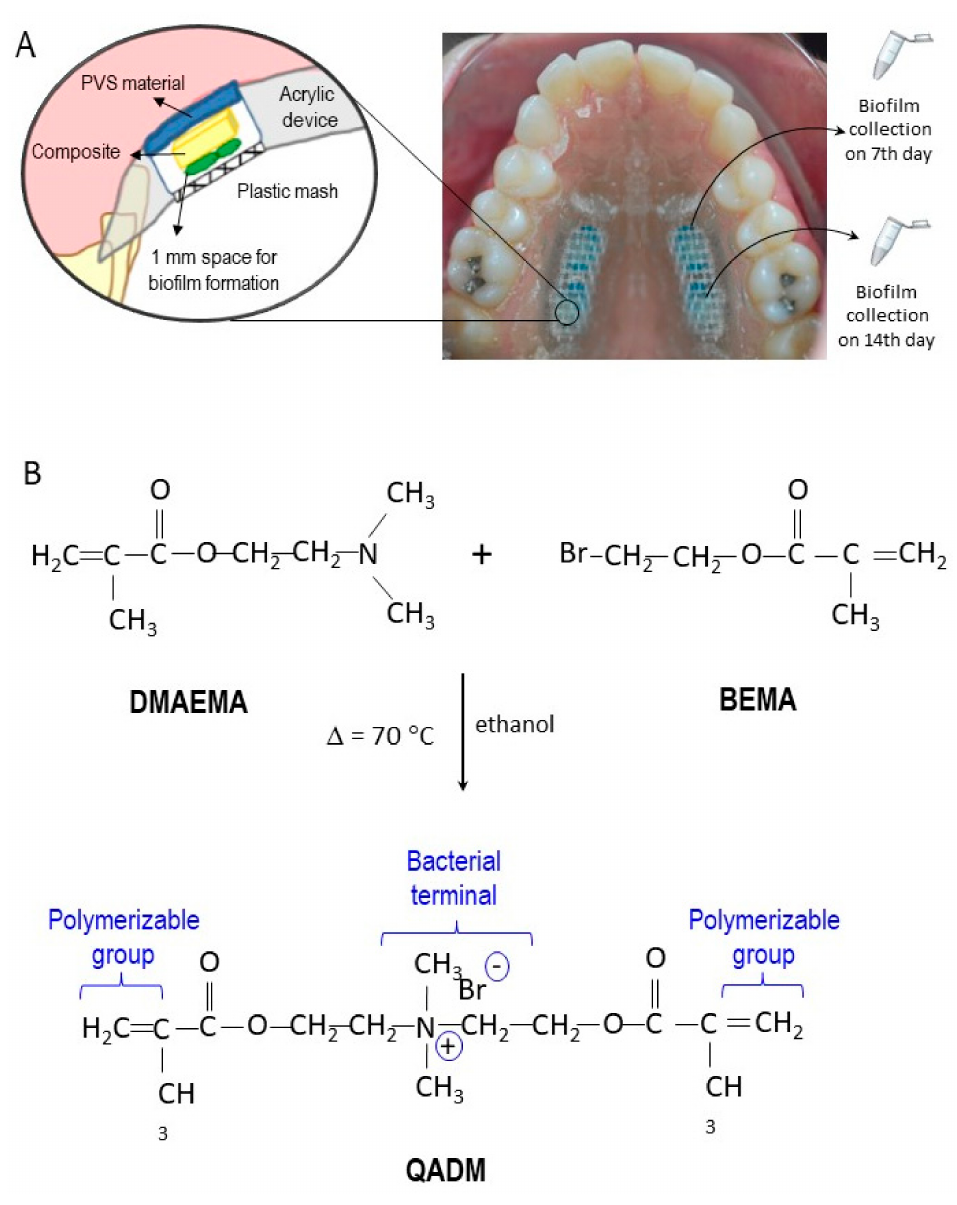
Figure 5. ( A ) In situ palatal devices used by 17 volunteers. Each device contained four slabs, two filled with the QADM composite on one side and two filled with the control composite on the other side. The slabs were held by polyvinyl siloxane (PVS) and covered with a plastic mash to avoid disturbance in the biofilm growth.The biofilm was collected from the surface of the specimens on the 7th and 14th days. The top-left is a magnified description showing details of biofilm formation over the composite specimens inside the device. ( B ) The synthesis route of the bis(2-methacryloyloxyethyl) dimethylammonium bromide monomer via a Menshutkin reaction and the details for dual-polymerizable groups and the bacterial terminal. BEMA: 2-bromoethyl methacrylate; DMAEMA: 2-( N,N -dimethylamino)ethyl